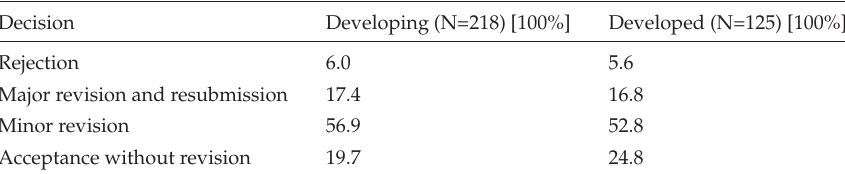
Table 4: Recommendations and country of reviewers’ institutional affiliation